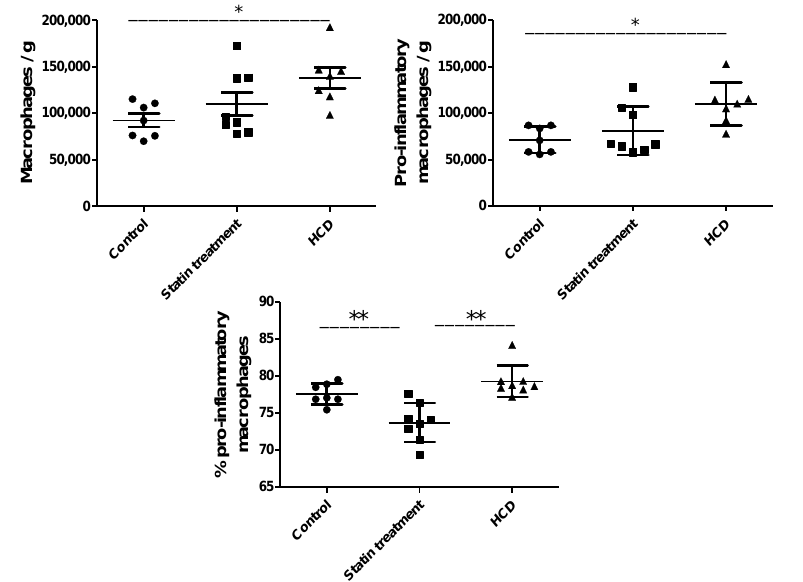
Figure 5. Numbers of macrophages (viable CD11b+ cells) and pro-inflammatory macrophages (CD11b+CD86+) per gram of rat adipose tissue and the proportion of pro-inflammatory macrophages of all the macrophages (CD11b+CD86+) in the control group ( n = 7), statin therapy ( n = 8), and HCD, high-cholesterol diet ( n = 8); data are expressed as the number of cells per gram and proportion (%) in means ± SD. * p < 0.05 and ** p < 0.01 .